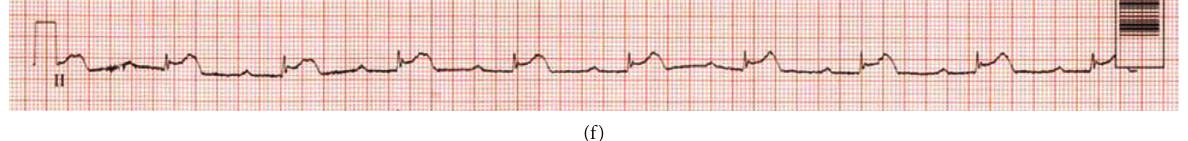
Figure 1: (a) Case 1: strip lead II and V5 showed signi fi cant sinus bradycardia 40 per minute with 3:1 high-grade AV block. (b) Case 2: strip lead II showed ST-segment elevation in lead II with complete heart block. (c) Case 3: strip lead II and V5 revealed pacing rhythm with complete heart block. (d) Case 4: strip leads V1, II, and V5 demonstrate junctional rhythm and isorhythmic AV dissociation. (e) Case 7: ECG showed ST-segment elevation in inferior leads with complete heart block. (f) Case 9: strip lead II shows ST segment with fi rst- degree AV block PR = 340